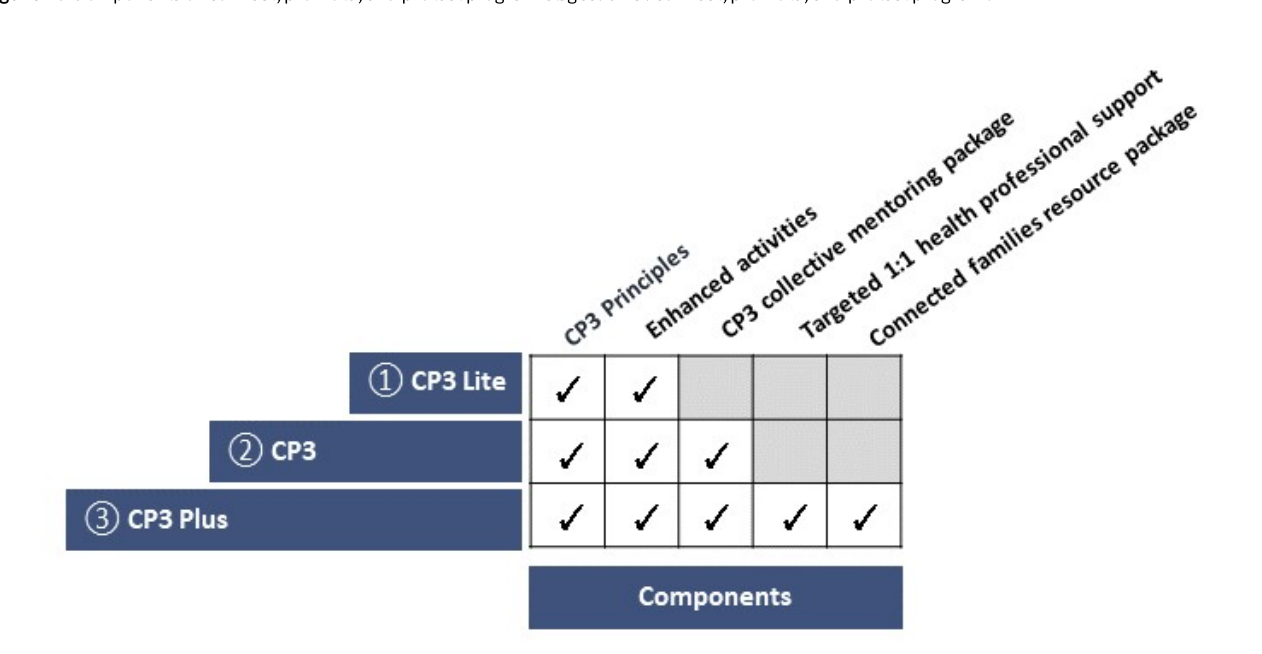
Figure 4. Components of connect, promote, and protect program stages. CP3: connect, promote, and protect program.